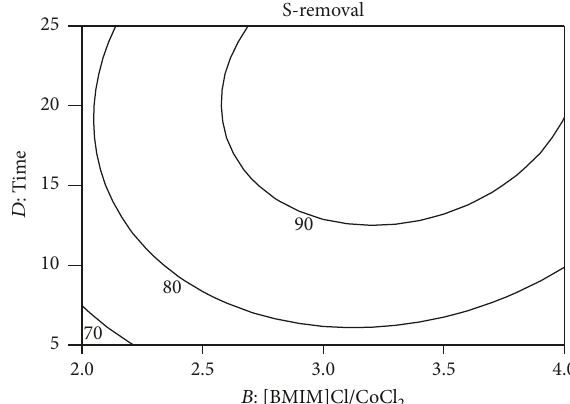
Figure 4: The contour plot about effect of PMS and temperature interaction on S-removal.